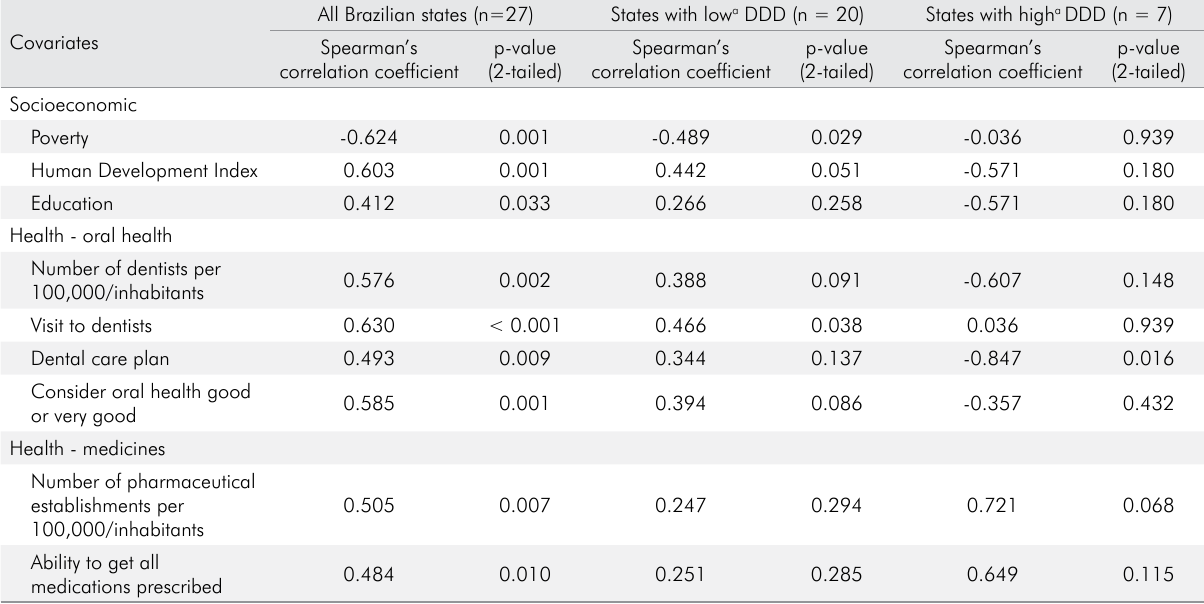
Table 4. Correlation between socioeconomic/health factors and quantities of opioid analgesics dispensing in Brazilian states, 2012. All Brazilian states Covariates